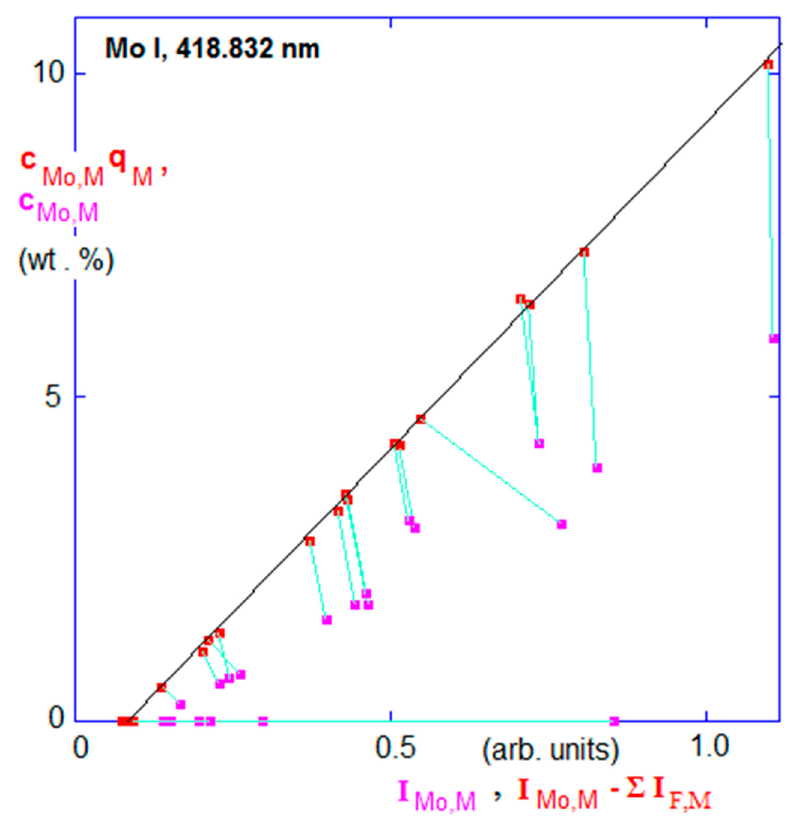
Figure 6. GDOES calibration curve of the Mo I line at 418.832 nm for analysis of molybdenum in various Ni alloys. Magenta points: raw data; red points: sputter rate-corrected and line interference- corrected data. Abscissa: line intensities; ordinate: plain (c E,M ) and sputter rate-corrected (c E,M .q M ) concentrations. Line interferences from other alloying elements (Fe, Ti, Nb, and W in this case) add an unwanted signal (light emission) that must be subtracted. This correction shifts the experimental points in this diagram to the left, while sputter rate correction shifts them in the vertical direction. Wavelength resolution was Δλ ≈ 0.07 nm. The slope of the trendline depicted is the reciprocal of the emission yield of Mo: 1/R Mo,418.832 nm . Reproduced from [39] with permission from The Royal Society of Chemistry.